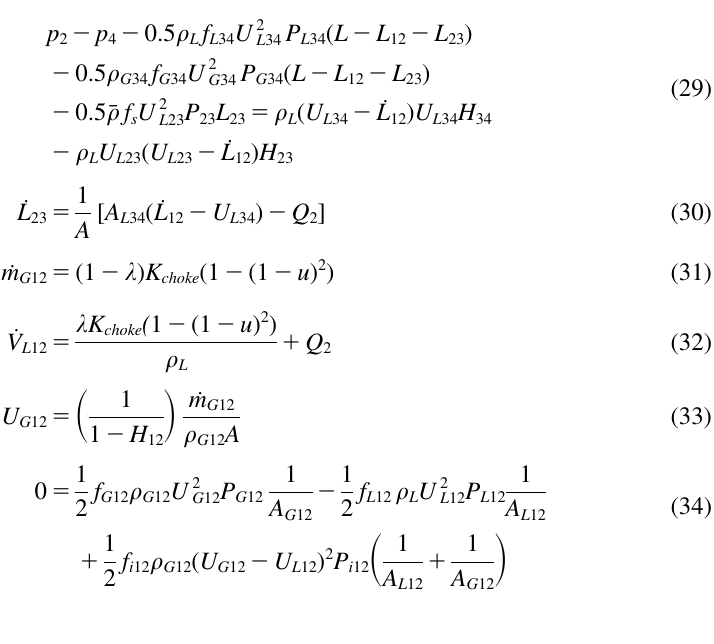
Figure 8. Illustration of the wetted perimeters P L , P G and P i and the phase areas A L and A G in a pipe